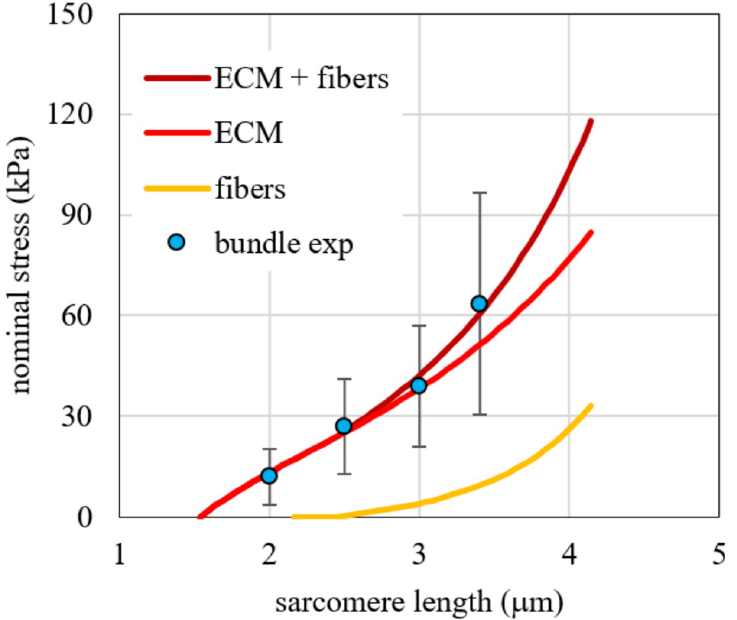
Fig 5. Comparison between numerical results and experimental data for bundles. Comparison between numerical results obtained with Eq (9) and experimental data for bundles in terms of force per unit of bundle area vs. stretch. The contribution of all the fibres (yellow continuous line) and ECM (red continuous line) is shown separately and as combination (dark red continuous line).